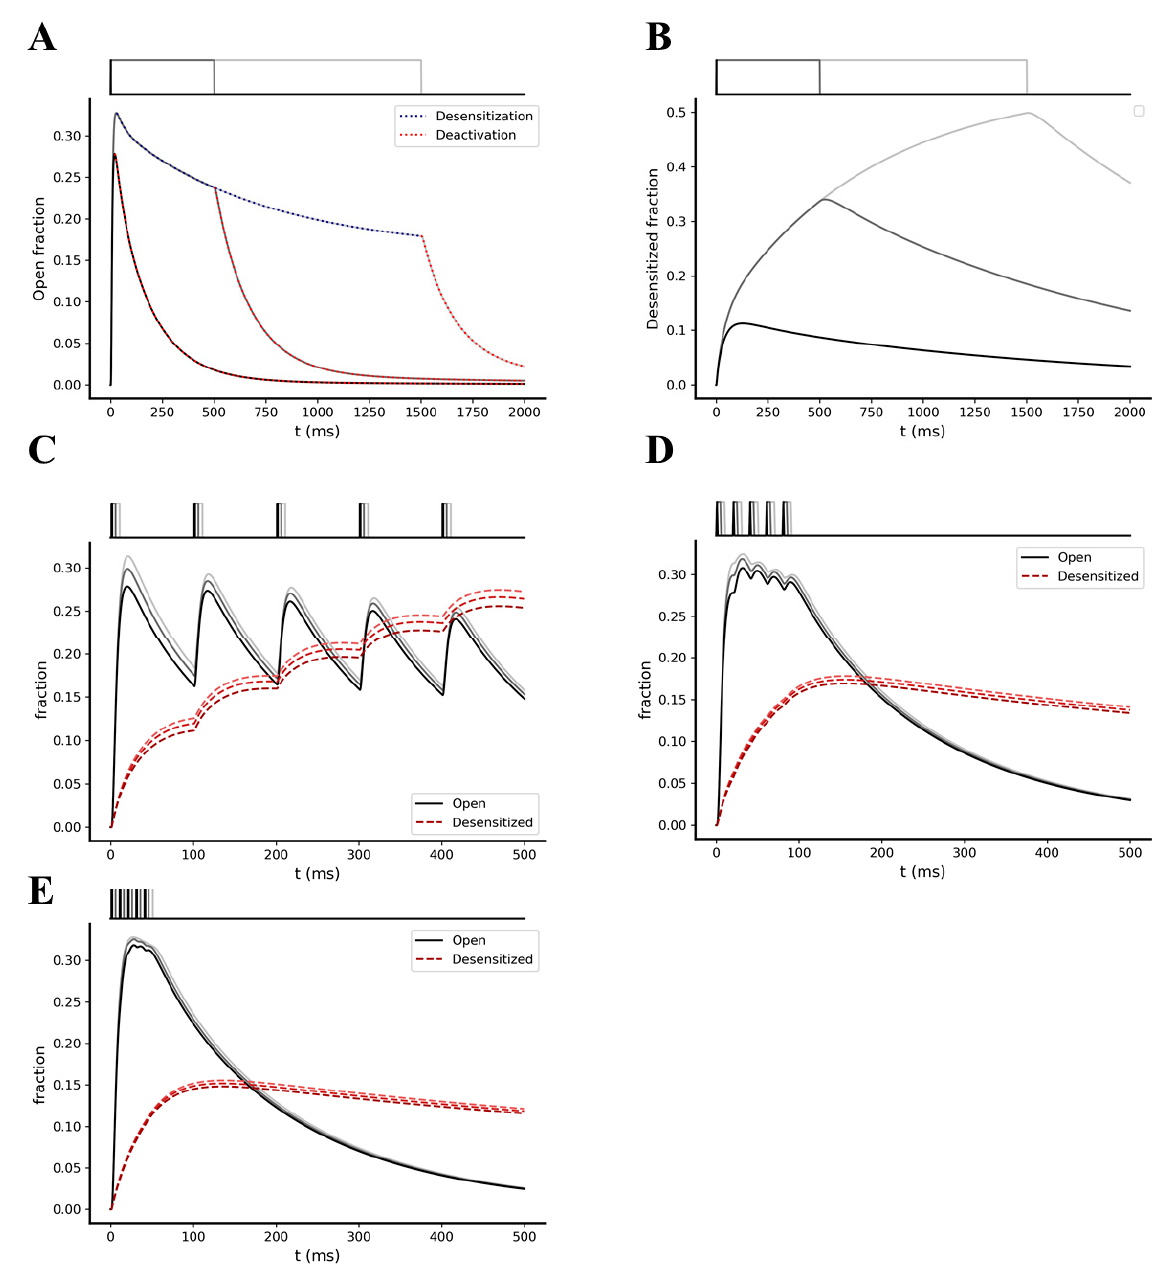
Figure 4. Opening and desensitization kinetics of the NMDA receptors. ( A ) Open fraction kinetics following a stimulation with a single glutamate pulse of 1mM amplitude and width of 1 ms (black), 500 ms (dark grey), and 1.5 s (light grey). Blue dotted trace shows the desensitization kinetics, while red dotted traces show the deactivation kinetics following glutamate removal from the virtual synaptic cleft. ( B ) Desensitized fraction kinetics following a stimulation with a single glutamate pulse of 1mM amplitude and width of 1 ms (light grey), 5 ms (dark grey), and 10 ms (black). ( C – E ) Kinetics of open and desensitized fractions following pre-synaptic stimulations with a burst composed of 5 glutamate pulses, with glutamate pulse amplitude of 1 mM, pulse width of 1 ms (black), 5 ms (dark grey), and 10 ms (light grey) and an intra-burst frequency of 10 Hz ( C ), 50 Hz ( D ), and 100 Hz ( E ).